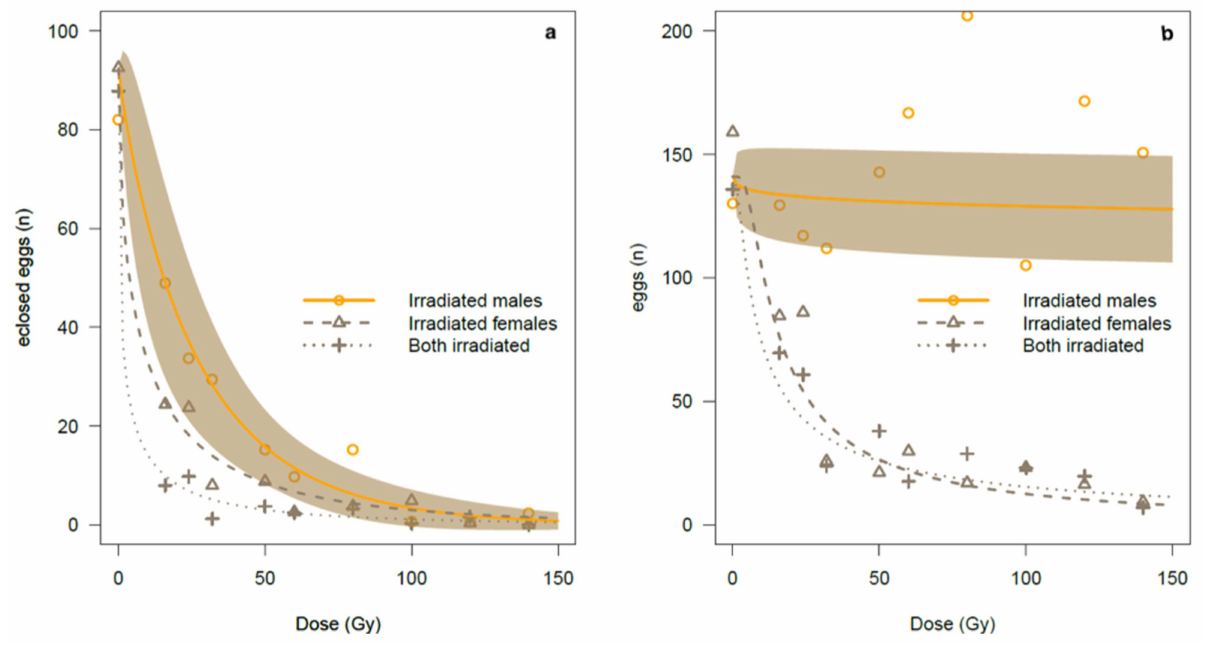
Figure 1. Comparison between three treatments (irradiated males only, irradiated females only, and both genders irradiated) on the number of eggs eclosed. Data were fitted by a Weibull model. For clarity, the 95% CI is shown only for the curve irradiated males × fertile females